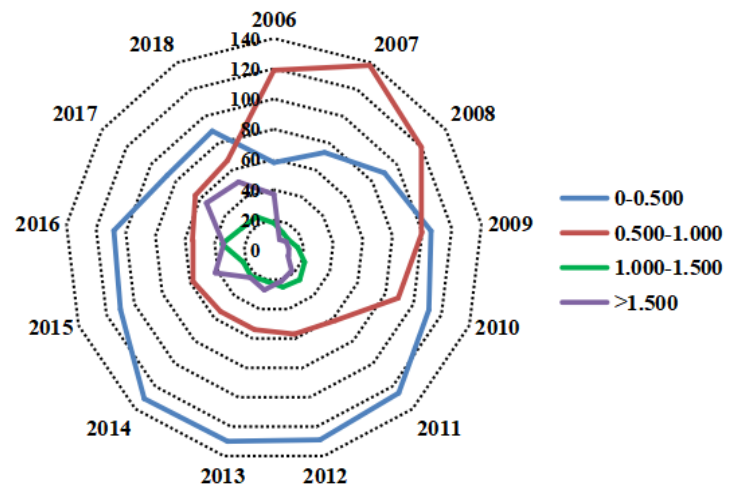
Figure 2. The Distribution characteristics of the urban GSDL in China from 2006 to 2018.